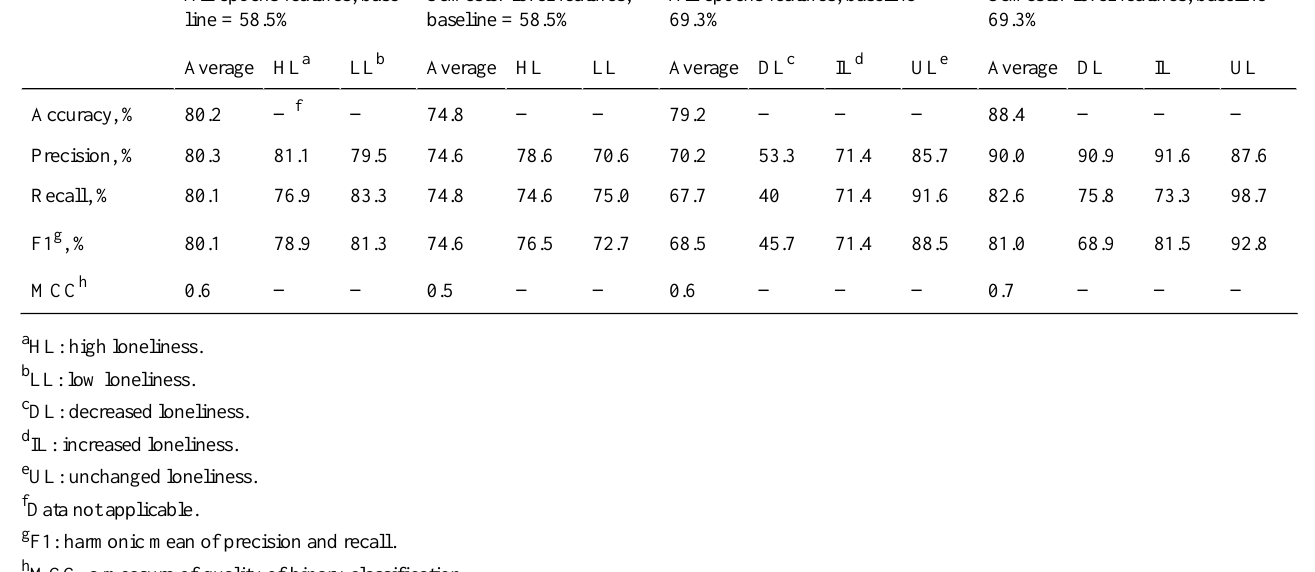
Change in lonelinessLoneliness